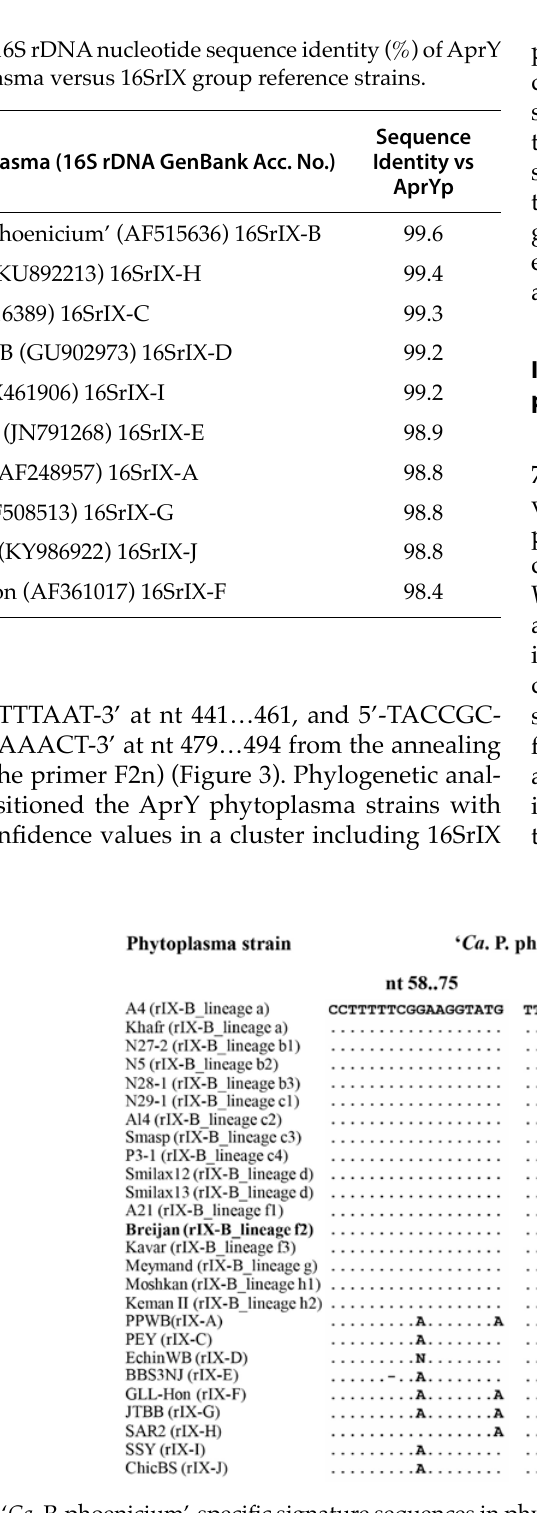
Figure 3. ‘ Ca . P. phoenicium’-specific signature sequences in phytoplasma strains of 16SrIX subgroups. Nucleotide position of each signature sequence is calculated from the annealing site of the primer